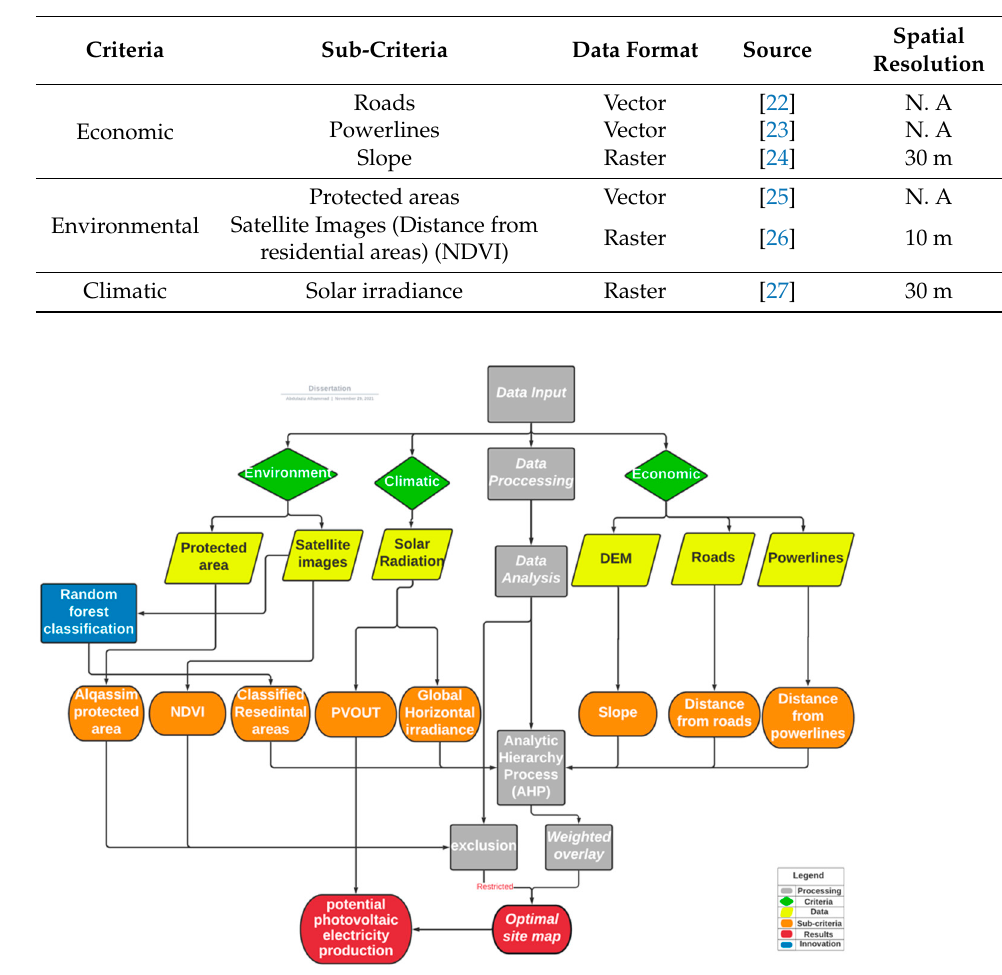
Table 2. Thematic layer datasets used in the geospatial analysis model.